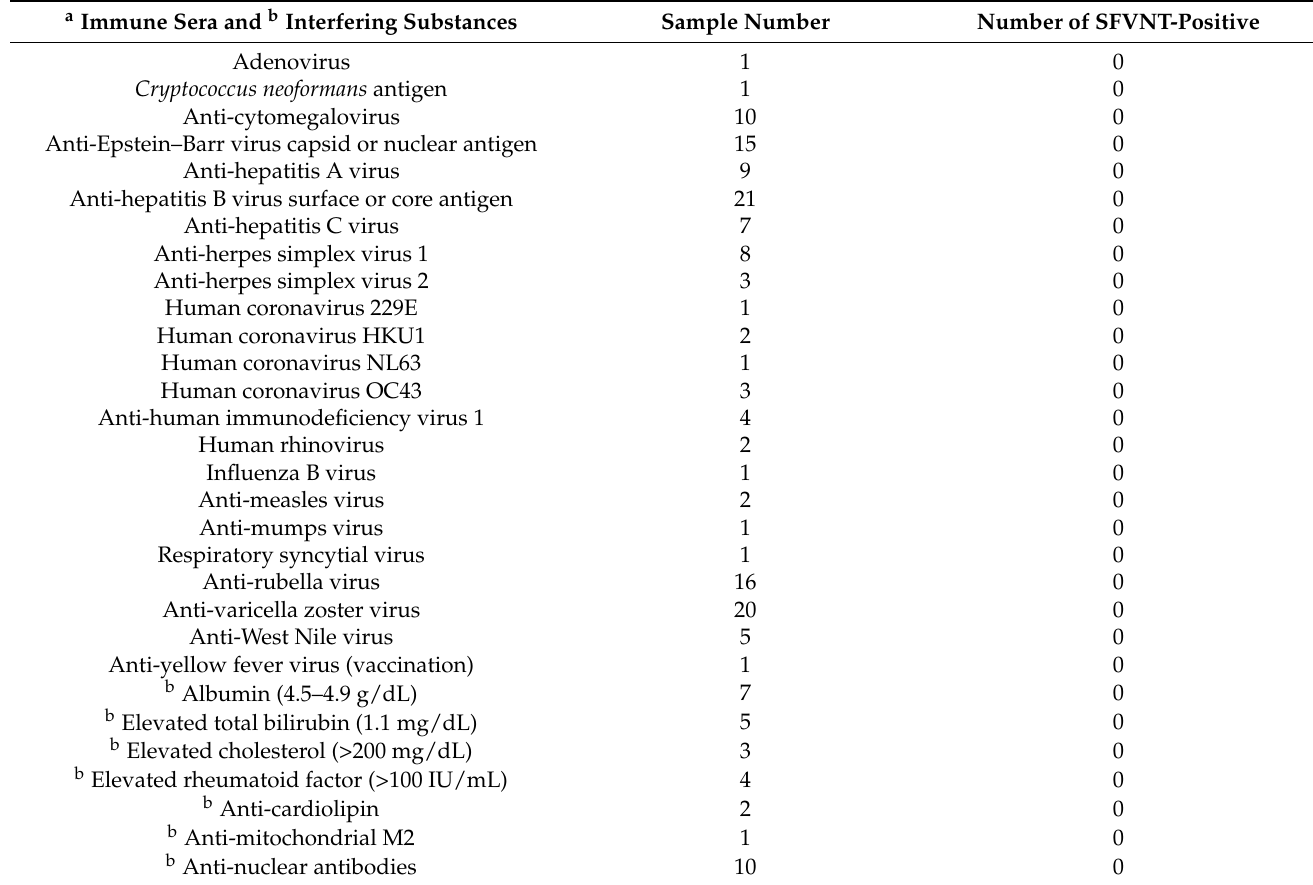
Table 2. Cross-reactivity of the single-round infection fluorescent SARS-CoV-2 virus ( ∆ ORF3–E mNG SARS-CoV-2) neutralization test